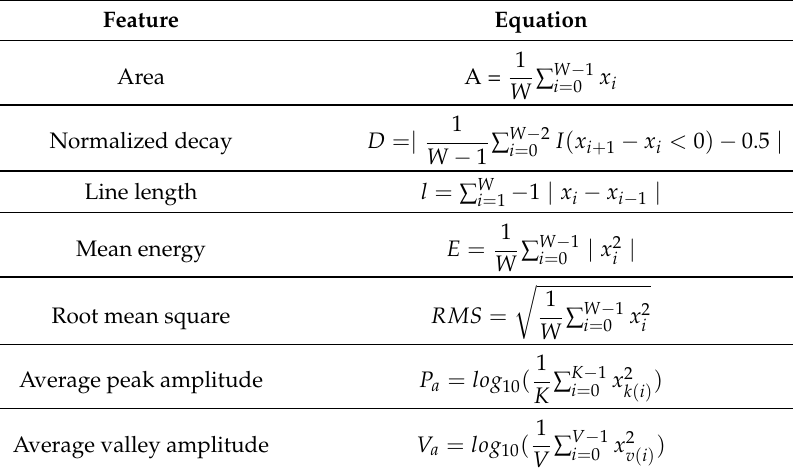
Table 1. Time-domain features of the EEG